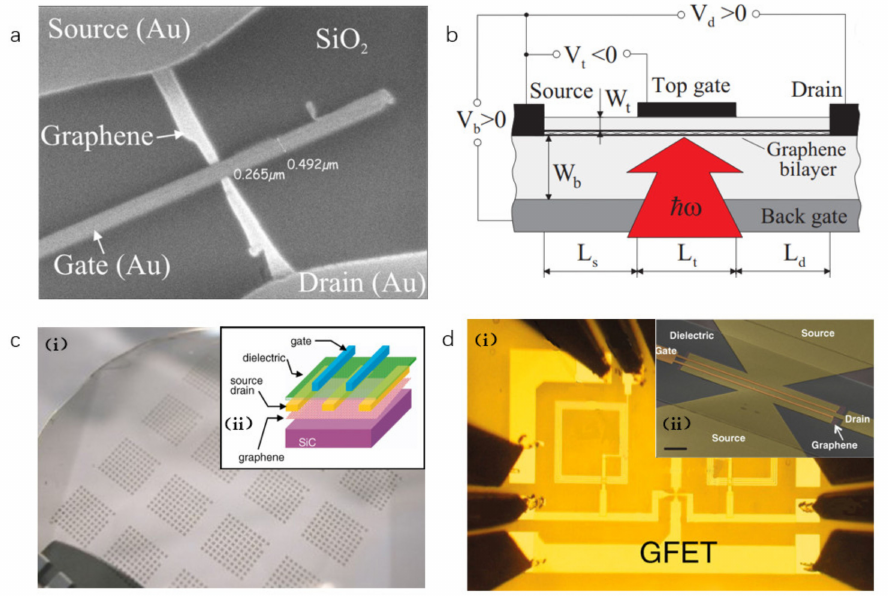
Figure 7. ( a ) The SEM image of a graphene device. Reprinted with permission from ref. [94]. Copyright 2021 Copyright Clearance Center. ( b ) Schematic view of a graphene terahertz